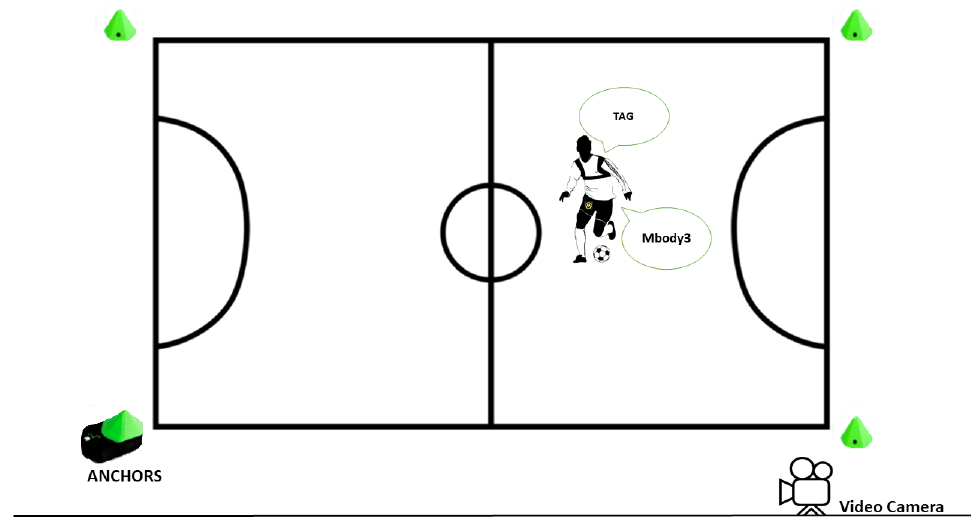
Figure 1. Representative Illustration of the